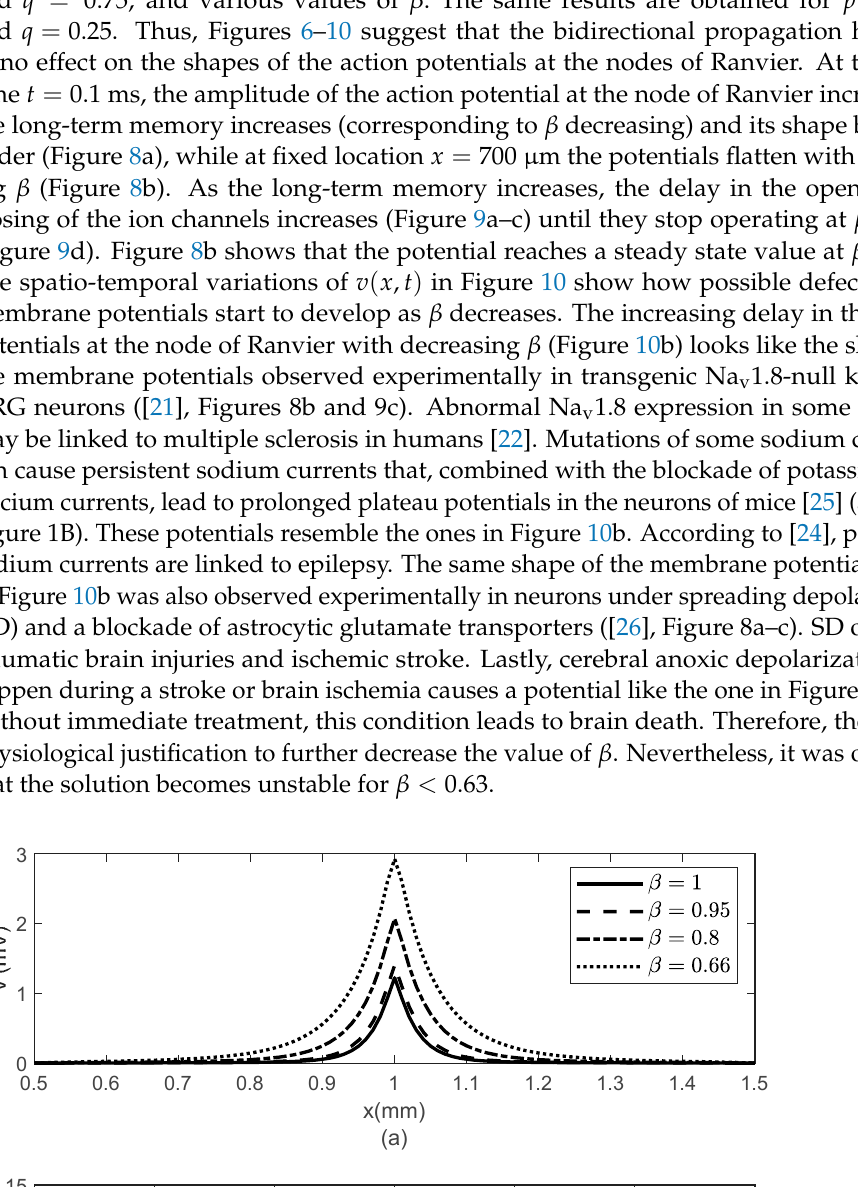
Figure 9. Time variations of the gating variables 𝑛(𝑡) (red), 𝑚(𝑡) ( blue), and ℎ(𝑡) (green), ob- tained by solving the fractional Hodgkin–Huxley Equations (35)–(38) for ( a ) 𝛽 = 1 , ( b ) 𝛽 = 0.95 , ( c ) 𝛽 = 0.8 , and ( d ) 𝛽 = 0.66. Here, 𝑝 = 0.25, 𝑞 = 0.75, and 𝛼 = 0.65 .